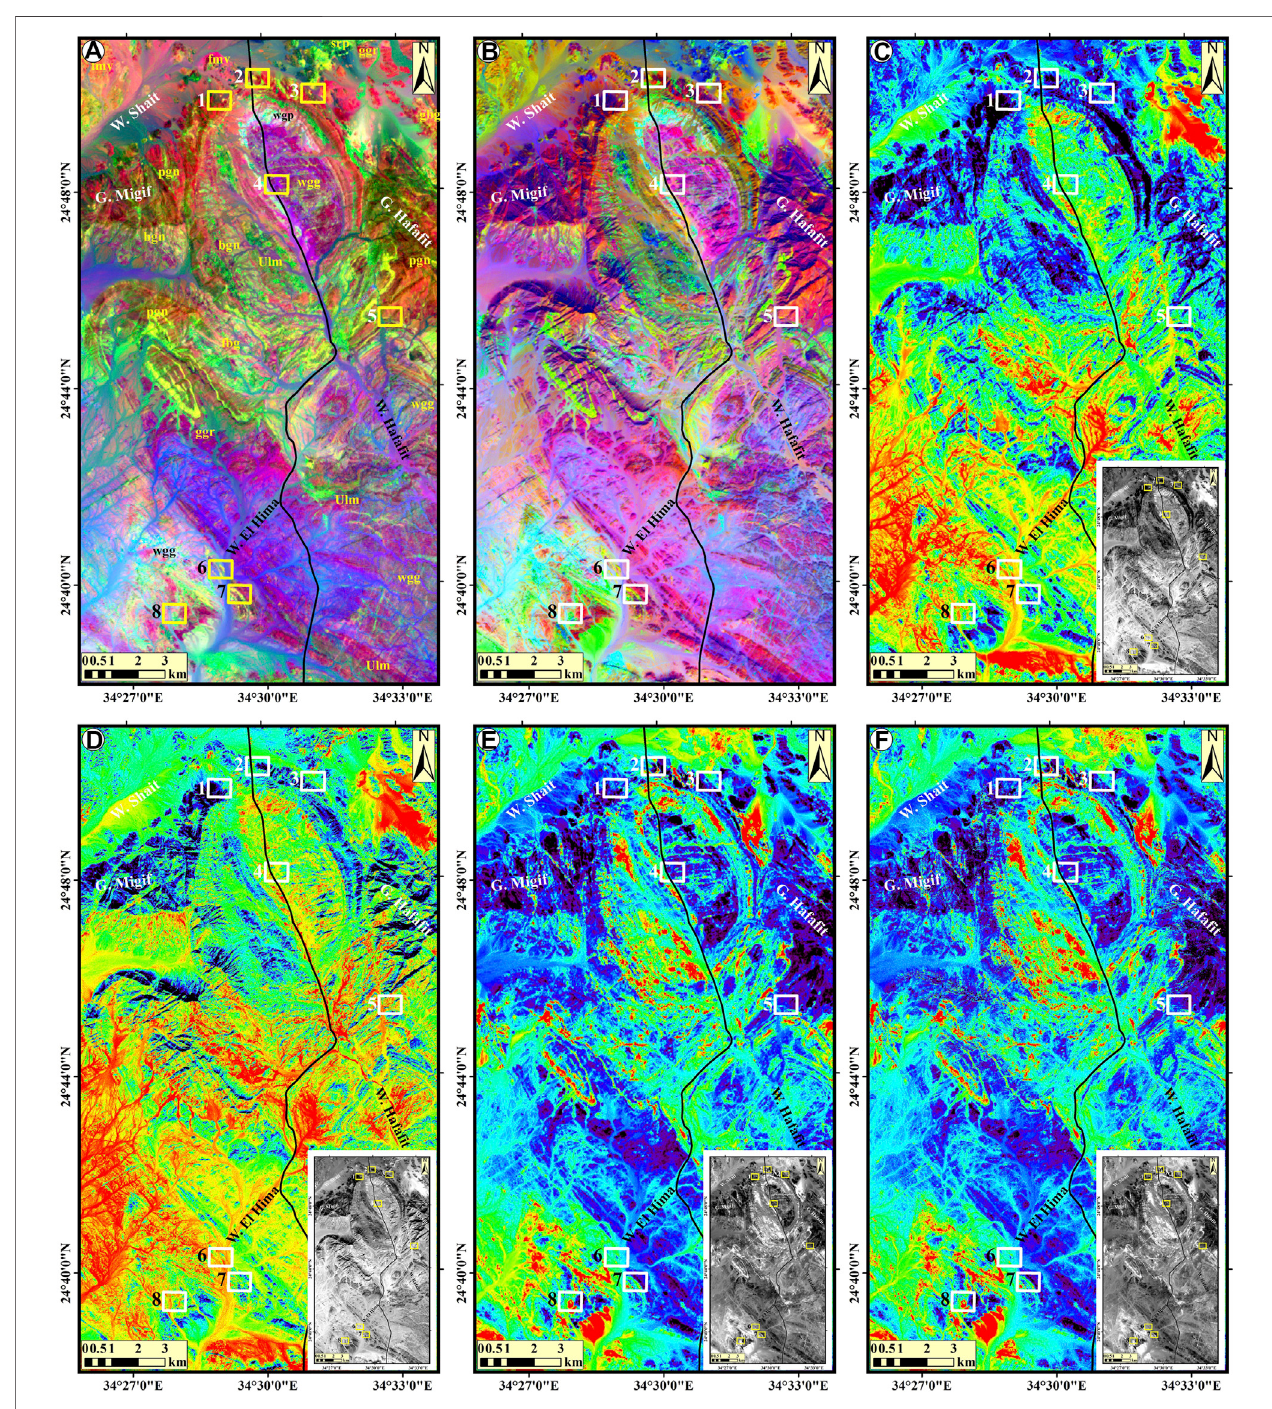
FIGURE 5 | (A) Landsat-8 (MNF-531) and (B) Decorrelation stretch of Sentinel-2A (RGB-12118) discriminate the lithological contacts. Mineralogical detection (C) Landsat-8 (4/2) and (D) Sentinel-2A (4/2) for mapping iron oxides, (E) Land-sat-8 (6/7) and (F) Sentinel-2A (11/12) for mapping hydroxyl/clay minerals. The yellow and white boxes represent the selected areas. Note: the band ratio (C – F) is offered by the density slice method (high ratio values shown in red). Inset gray scale band ratios versions are also presented in (C – F) .